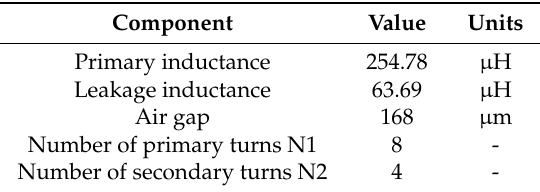
Table 1. Basic transformer